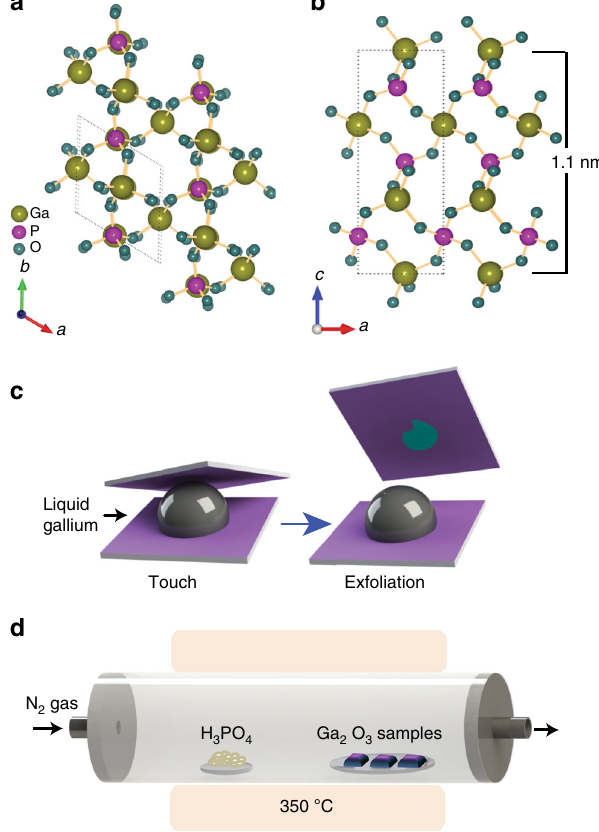
Fig. 1 Crystal structure and printing process of 2D GaPO 4 nanosheets. Ball and stick representation of the synthesised GaPO 4 crystal: a top view and b side view showing an out-of-plane structure exhibiting unit cell parameter c = 11.05 Å. c Schematic illustration of the van der Waals 2D printing technique of Ga 2 O 3 nanosheet from liquid metal gallium. d Schematic setup for the chemical vapour phase reaction system used for